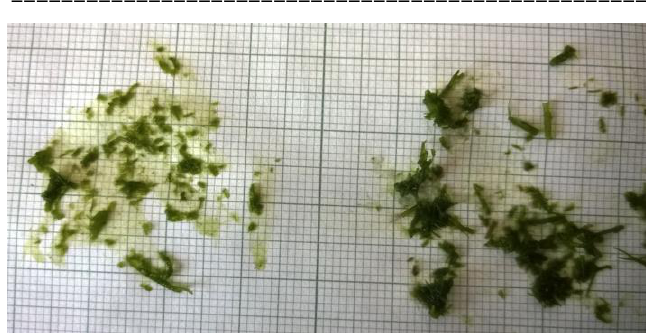
Fig. 2. Macrophyte Ceratophyllumdemersum , fraction sizes on mm paper (on left side smaller fractions, on right bigger fractions). distilled water (30 ml), buffer Na-HCO 3 (3 g/l) and 20 ml of inoculum were added. Afterwards, the bottles were flushed with CO 2 , rubber caps were secured with crimping tool. After the bottles were shaken and put into an incubator at